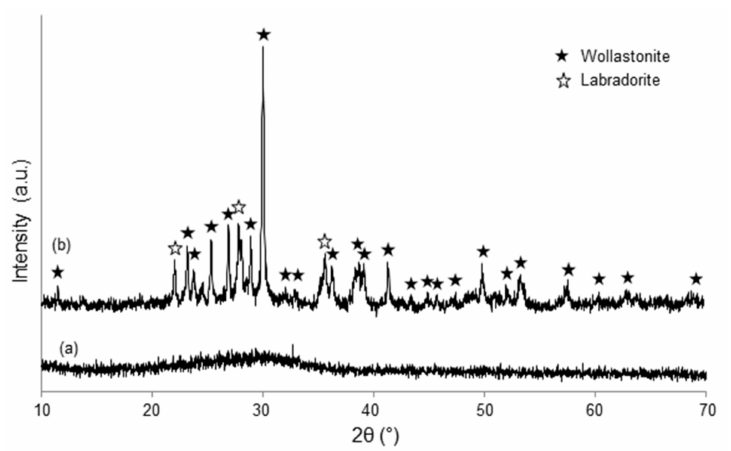
Figure 3. Wide-angle XRD pattern of ( a ) as-quenched SCNA-5Cu and ( b ) SCNA-5Cu thermally treated at 950 ◦ C for 3 h.